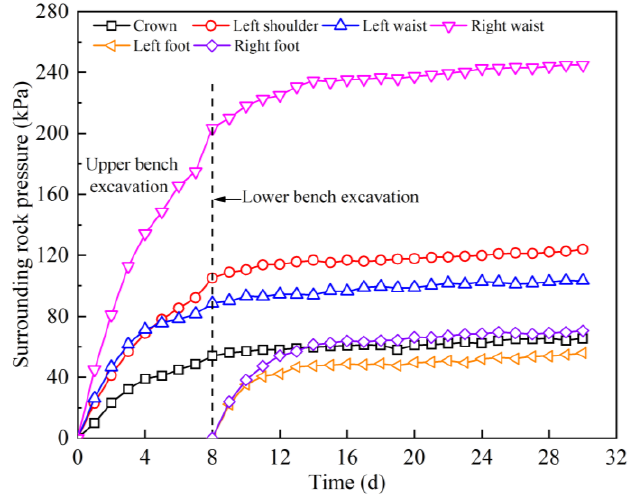
Figure 29. Duration curves of the surrounding rock pressure.